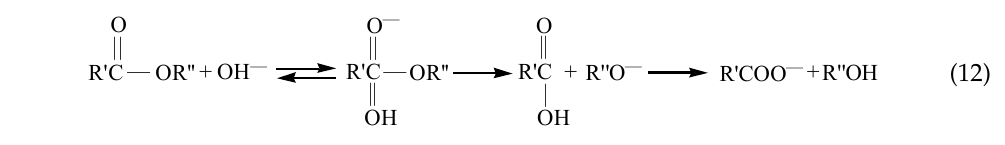
Figure 13. The degradation mechanism of the GFRP bars and the HFRP bars in water and the alkaline solution.